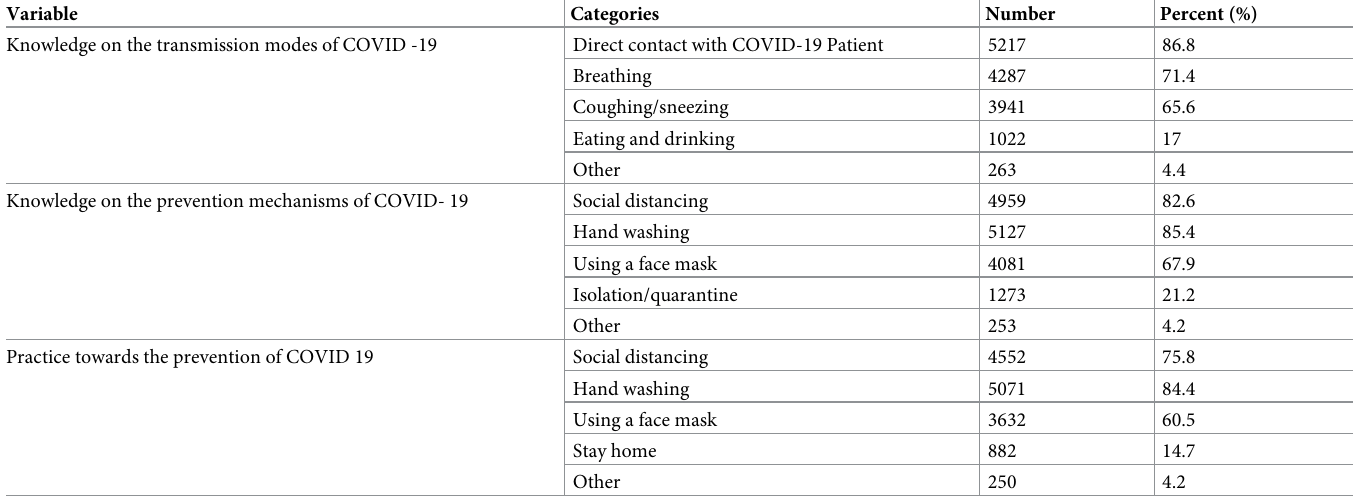
Table 2. Knowledge on transmission, prevention and practice towards the prevention of COVID-19 among most likely to be high risk groups in Addis Ababa, Ethi- opia, 2020. Variable